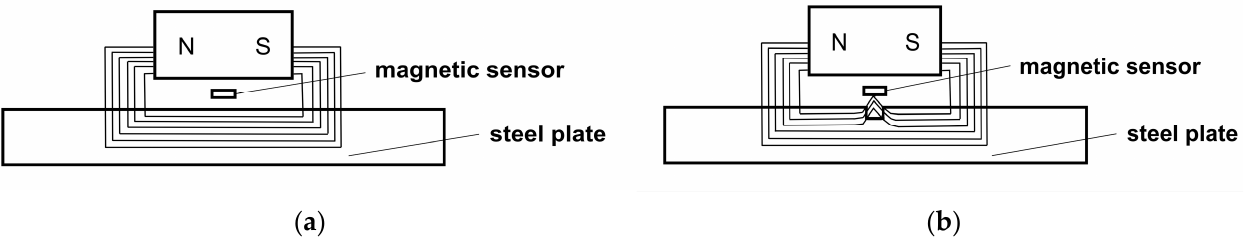
Figure 1. Schematic diagram of the magnetic flux leakage detection principle. ( a ) no defect; ( b ) defective.